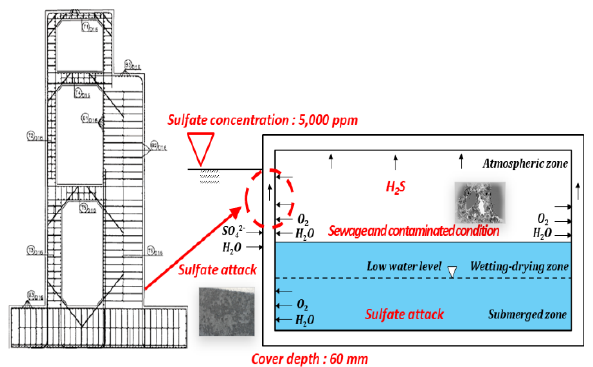
Figure 4. Schematic diagram for the RC structure exposed to sulfate attack. 185